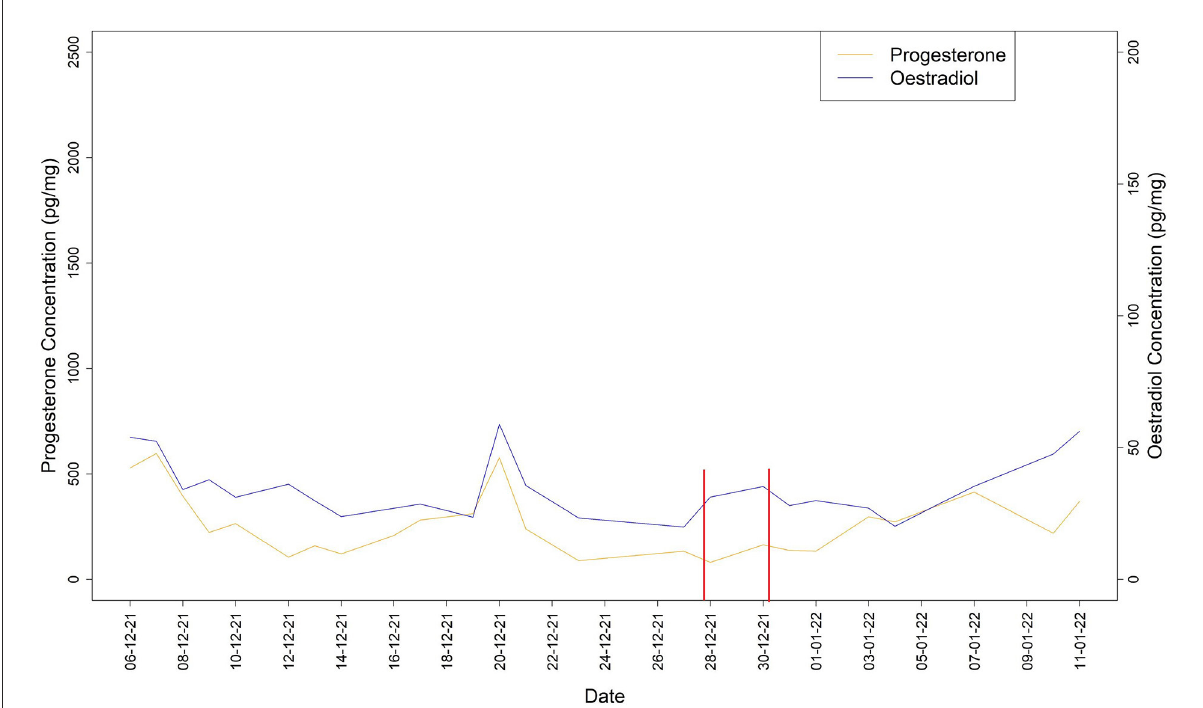
FIGURE2 Oestradiol and progesterone concentrations during the breeding period. Vertical bars denote the ovulation